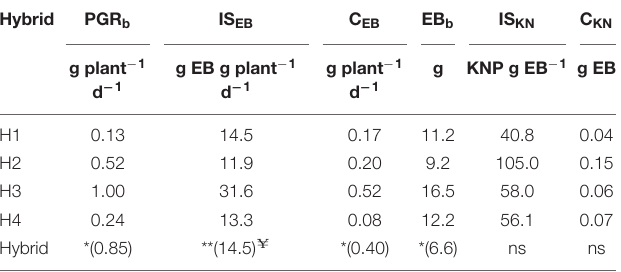
TABLE 4 | Yield of four genotypes (H1, H2, H3, and H4) tested at three environments (Env 3, Env 4, and Env 5), and four stands density treatments (D1, D2, D3, and D4 were 5, 7, 9, and 11 plants m − 2